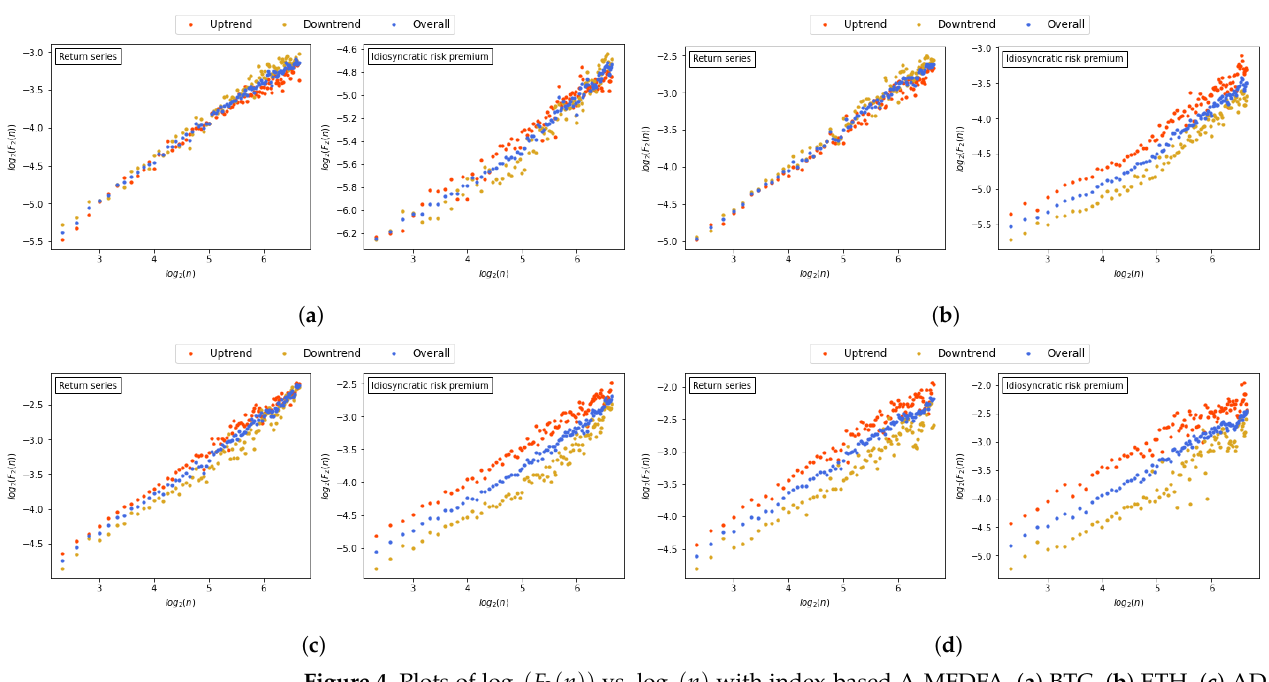
Figure 4. Plots of log ( d )